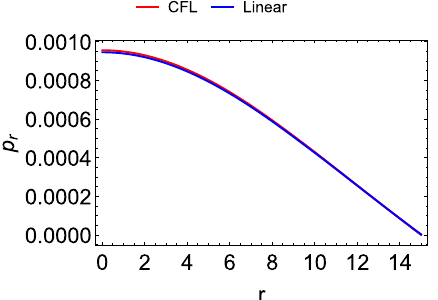
Fig. 2 Variation of radial pressure with radial coordinate Duetothecomplexityofthesolution,weshowgraphically